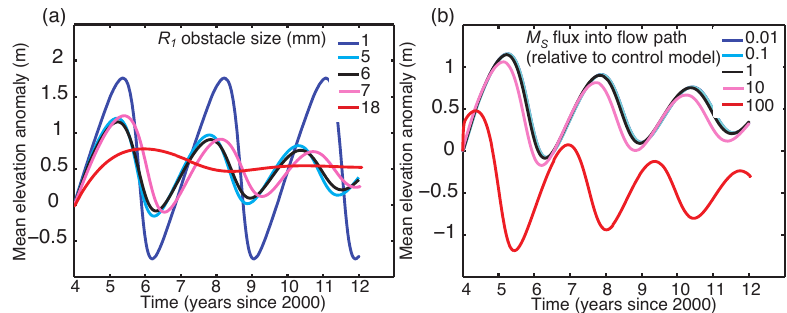
Figure 11. Sensitivity of canal model to (a) mean obstacle size ( R 1 ) and (b) mean basal melt rate ( M S ).